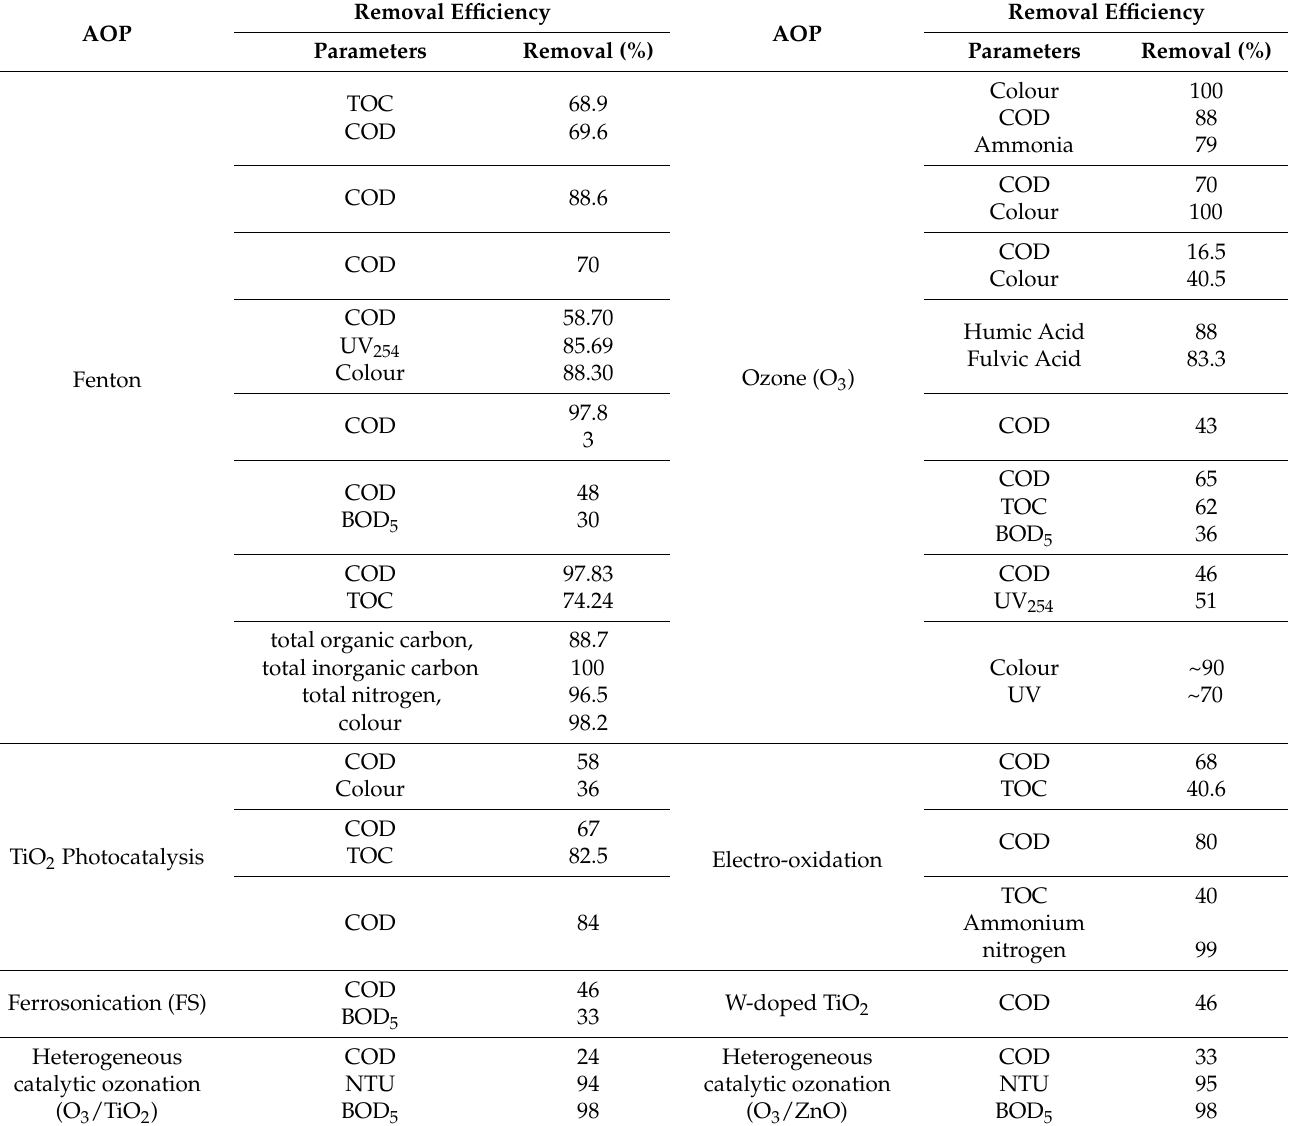
Table 5. Summary of advanced oxidation processes (AOPs) in treating